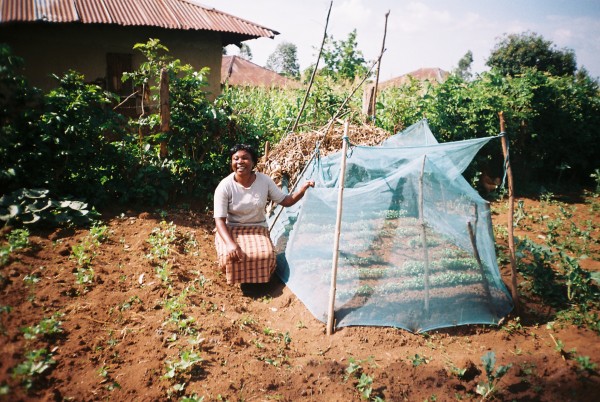
Monica Khagoni (Ingidi, Kenya) with her mosquito-net shelter to protect Artemisia annua seedlings from hailstones.